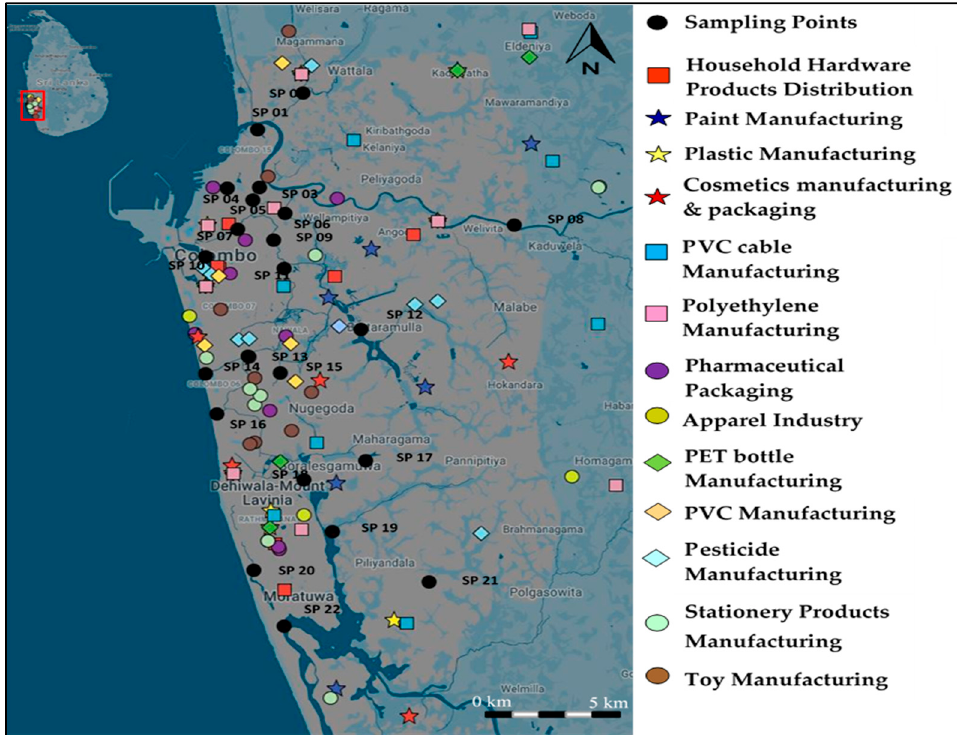
Figure 1. Sampling locations and the industries that have a potential for migration of phthalic acid esters (PAEs) from sub ‐ catchment areas.